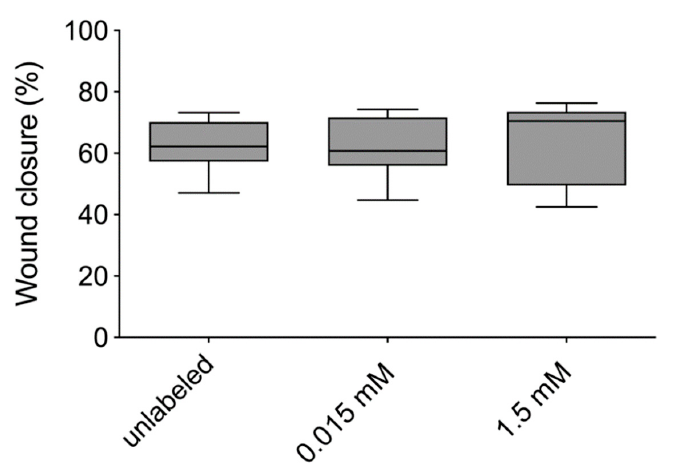
Figure 7. Scratch assay: To evaluate the influence of VSOPs-labeling on the migration ability of hASCs, the scratch assay was used. After 24 h, there was no remarkable difference between labeled and unlabeled cells.